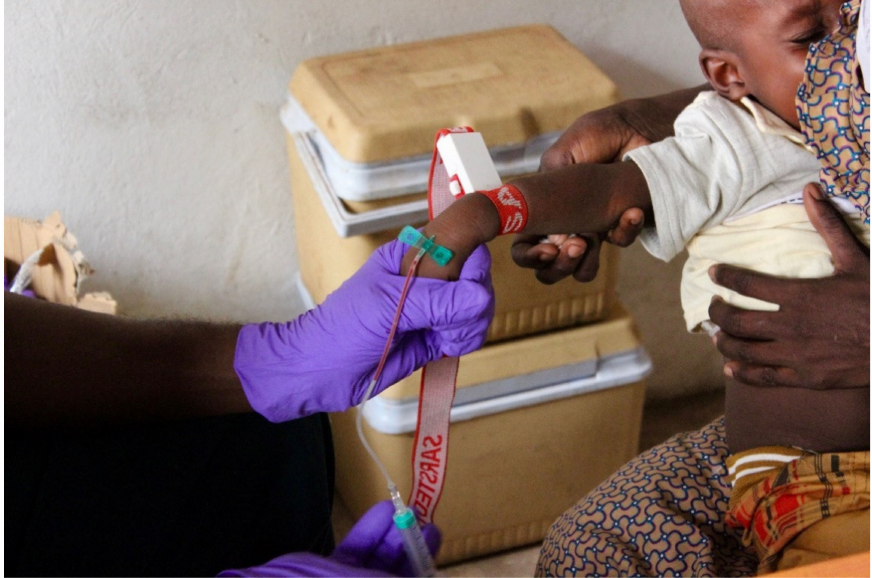
Figure 3. Photograph of blood drawing during a visit to the study